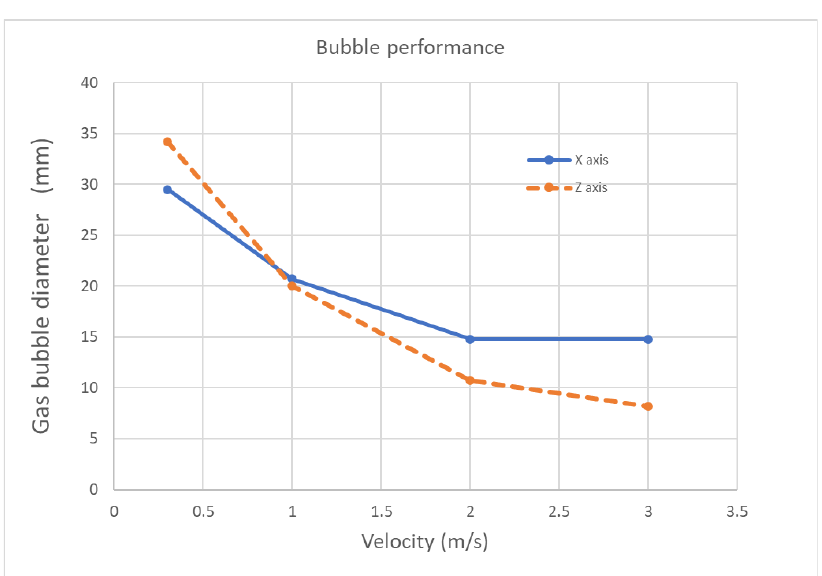
Figure 10. Transversal sections at d l = 20 mm with a rotating gas bubble.